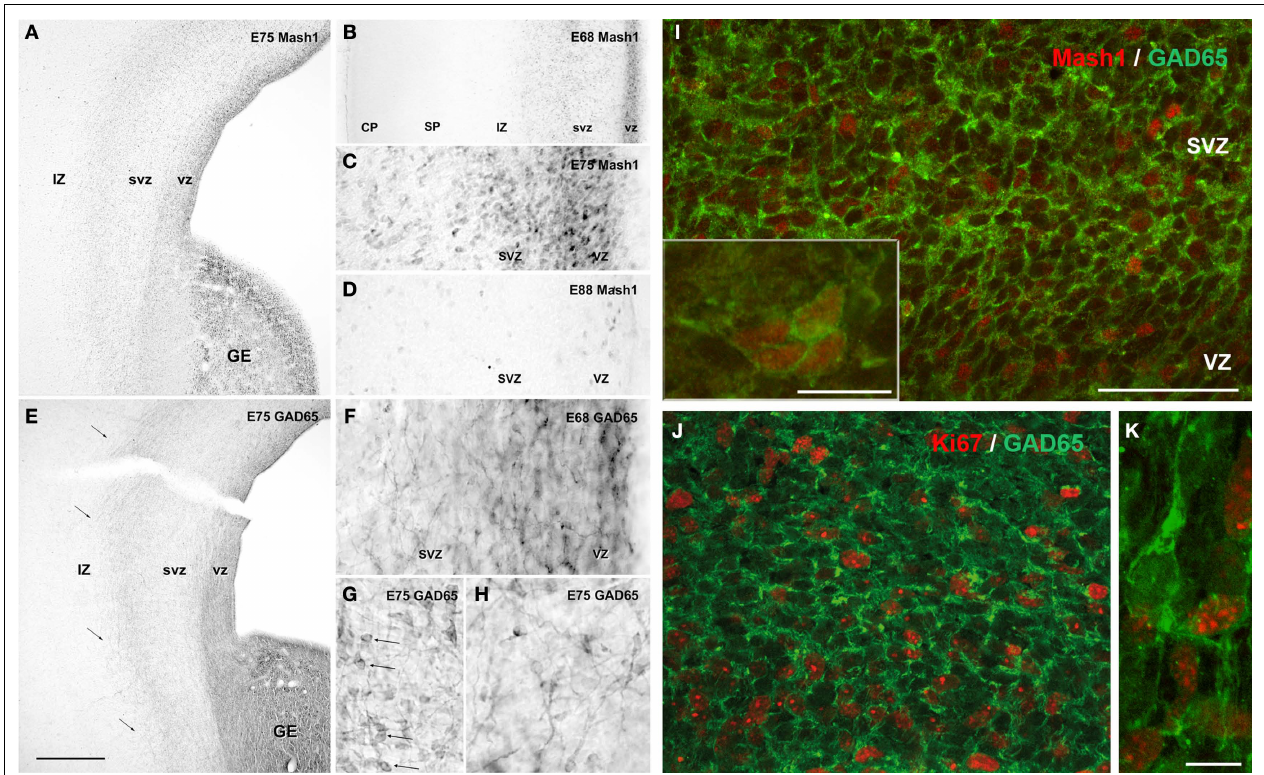
FIGURE 4 | Neurogenesis of GABAergic neurons in the ventral and dorsal telencephalon of monkey fetuses at embryonic day (E) 68, E75 and E88. (A–D) Mash1 expression. (A) At E75, Mash1 containing progenitors were present in the ganglionic eminence (GE) as well as in ventricular (VZ) and subventricular (SVZ) zone of the entire dorsal telencephalon. In both areas, the intensity of labeling for Mash1 decreased from the VZ to the SVZ. (B) At E68, the same pattern of labeling for Mash1 is already present in the VZ and SVZ of the dorsal telencephalon. No labeling is observed in the upper part of intermediate zone (IZ), the subplate (SP) and the cortical plate (CP). (C) Higher magnifi cation of panel (A) . The numerous Mash1 highly labeled cells located in the VZ and SVZ of the dorsal telencephalon. (D) At E88, end of neurogenesis, the intensity of labeling for Mash1 was strongly decreased as compared to E68 (B) and E75 (A,C) . (E–H) GAD65 expression. (E) At E75, GAD65-containing progenitors were present in the GE, but also in the proliferative VZ and SVZ of the dorsal telencephalon in contrast to earlier stages. The stream of migrating GAD65- containing neurons observed at E55 [compare with panel (B) in Figure 3 ] in the lower part of IZ and upper part of SVZ was still present (arrows). (F) At E68, similar labeling was already observed. In contrast to previous stages many migrating-like